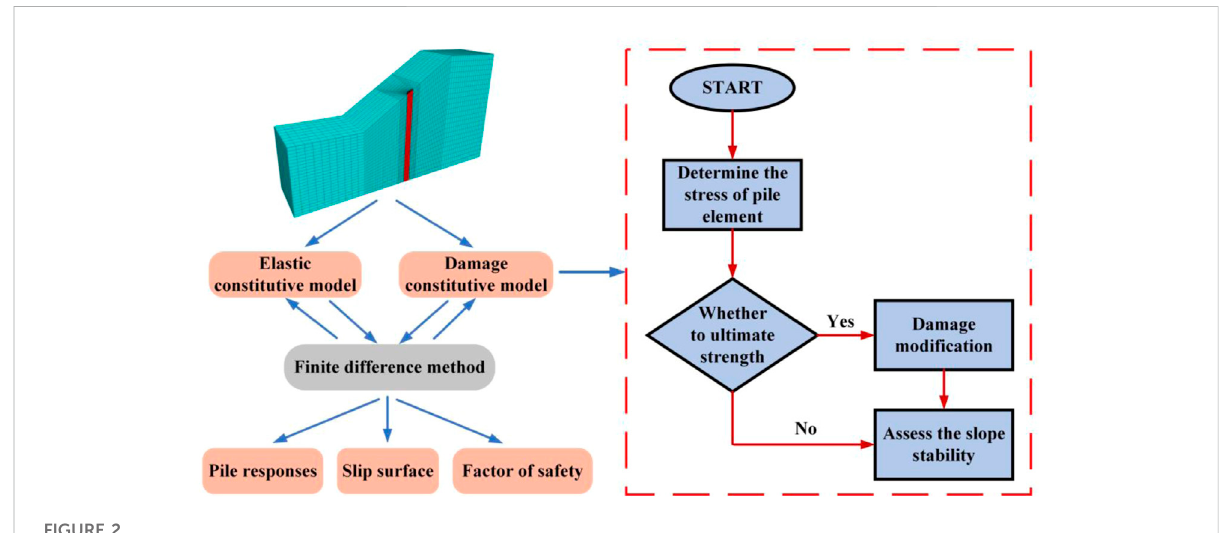
FIGURE 2 Schematic illustration of slope stability analysis.